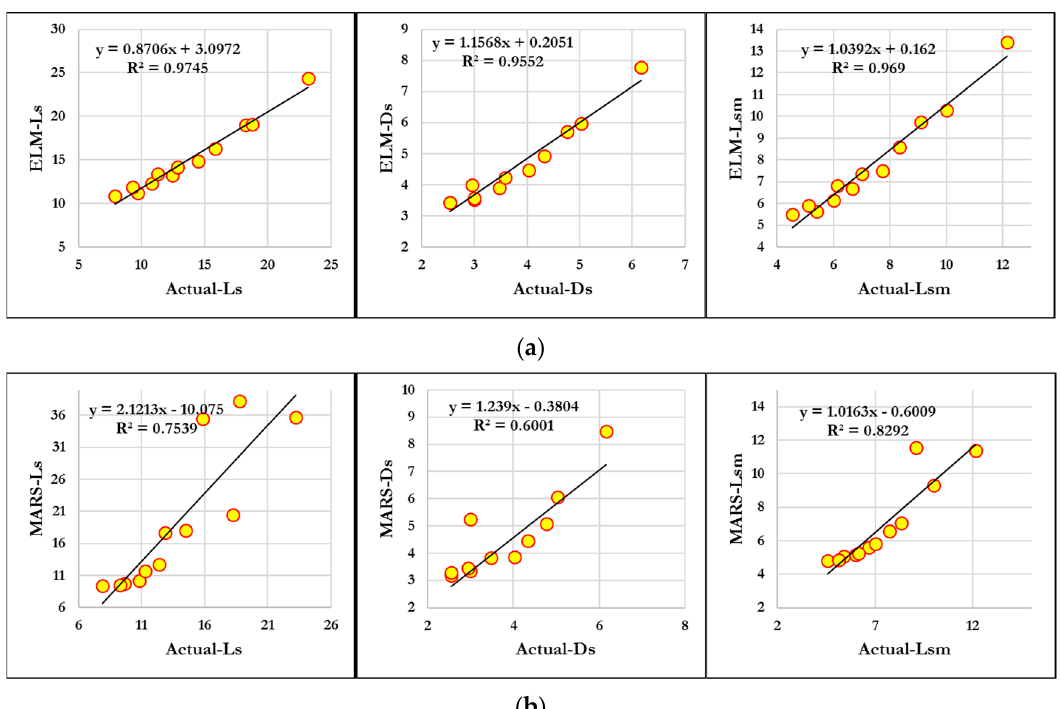
Figure 4. Scatter plots including the least square regression line and the coefficient of determination for the predicted scour-hole characteristics (Ls, Ds, Lsm) obtained using dimensional variables in ( a ) ELM and ( b ) MARS models.